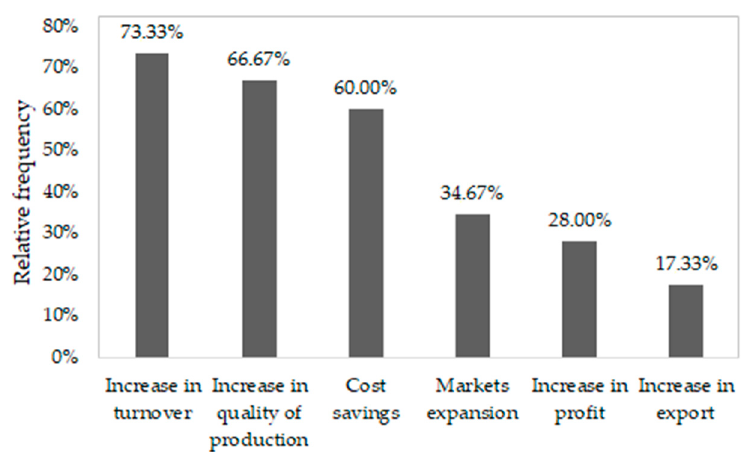
Figure 4. The impact of innovation activities on the economic results of family businesses.